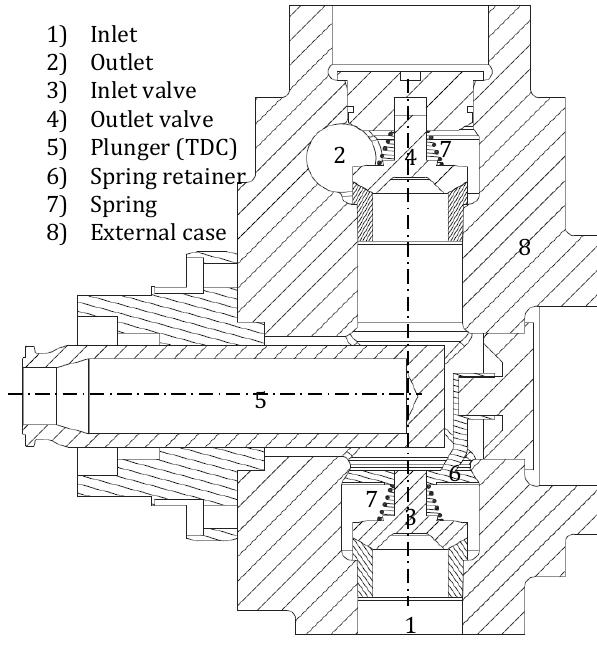
Figure 1. 2D section of the PD pump utilised to create the fluid volume and the mesh for the CFD. Nomenclature is provided.